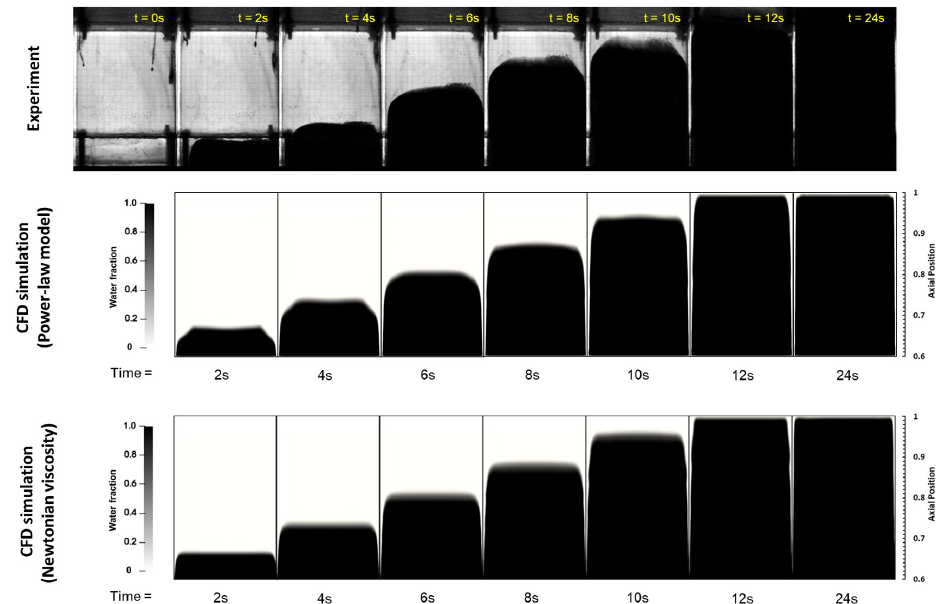
Figure 5. Experimental visualization ( top ) and CFD simulations ( bottom ) of interface evolution of water displacing 0.02 wt.% xanthan gum solution. The case is simulated with both power-law and effective Newtonian viscosity for